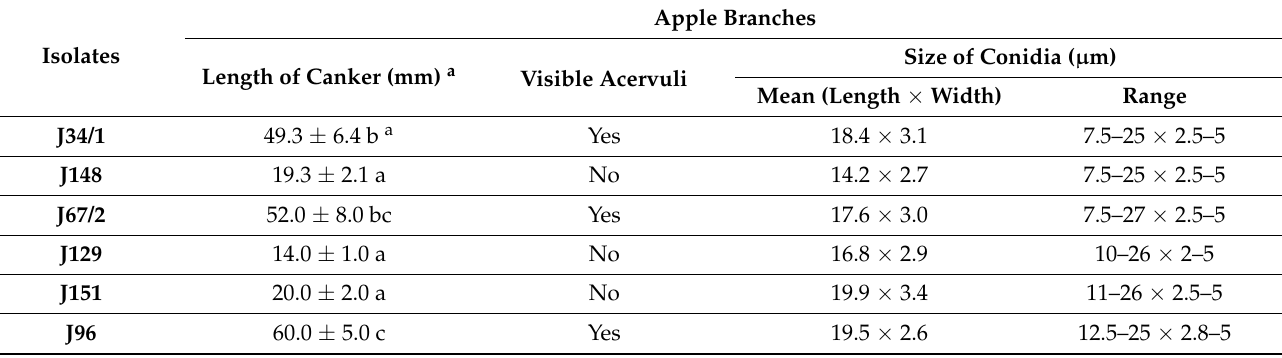
Figure 4. Neofabraea sp.: canker progression on inoculated apple branches. Table 3. Length of cankers (mm) and visibility of acervuli and conidial size ( µ m) on two-year-old apple branches inoculated with Neofabraea isolates one-year post inoculation. Apple Isolates